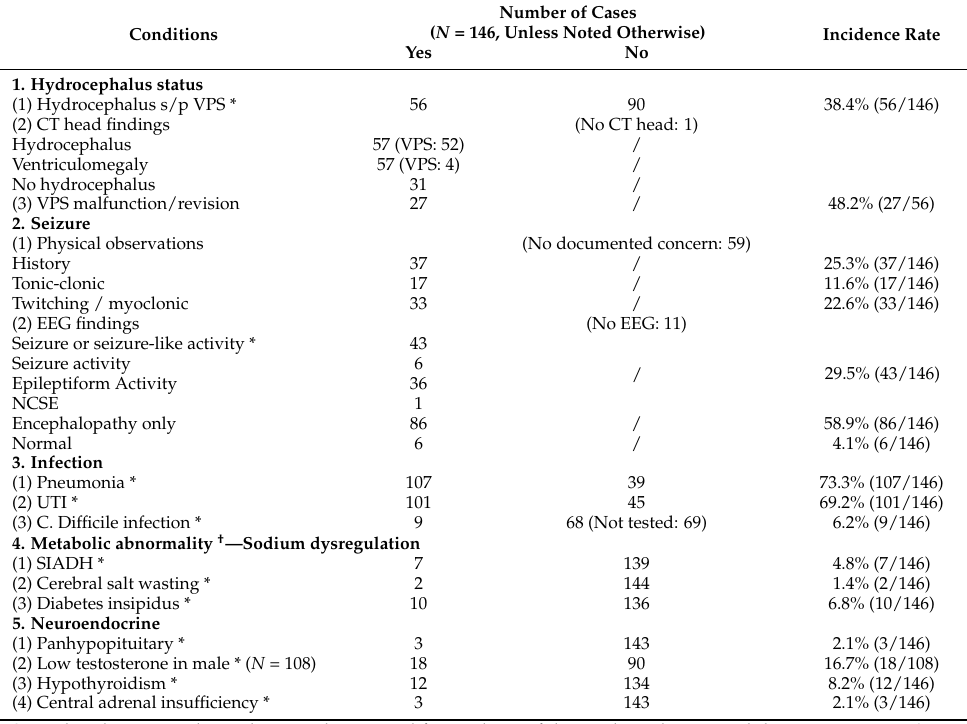
* Considered as one independent condition used for analysis of the total conditions and their concurrency ( N = 12 in this table). † Other metabolic abnormalities, including but not limited to potassium/calcium dysregulation, increased creatinine clearance, abnormal liver function panel, hyperglycemia, were seen in almost all patients most commonly transiently. Hyperammonemia was only tested in a very limited amount of patients as its clinical